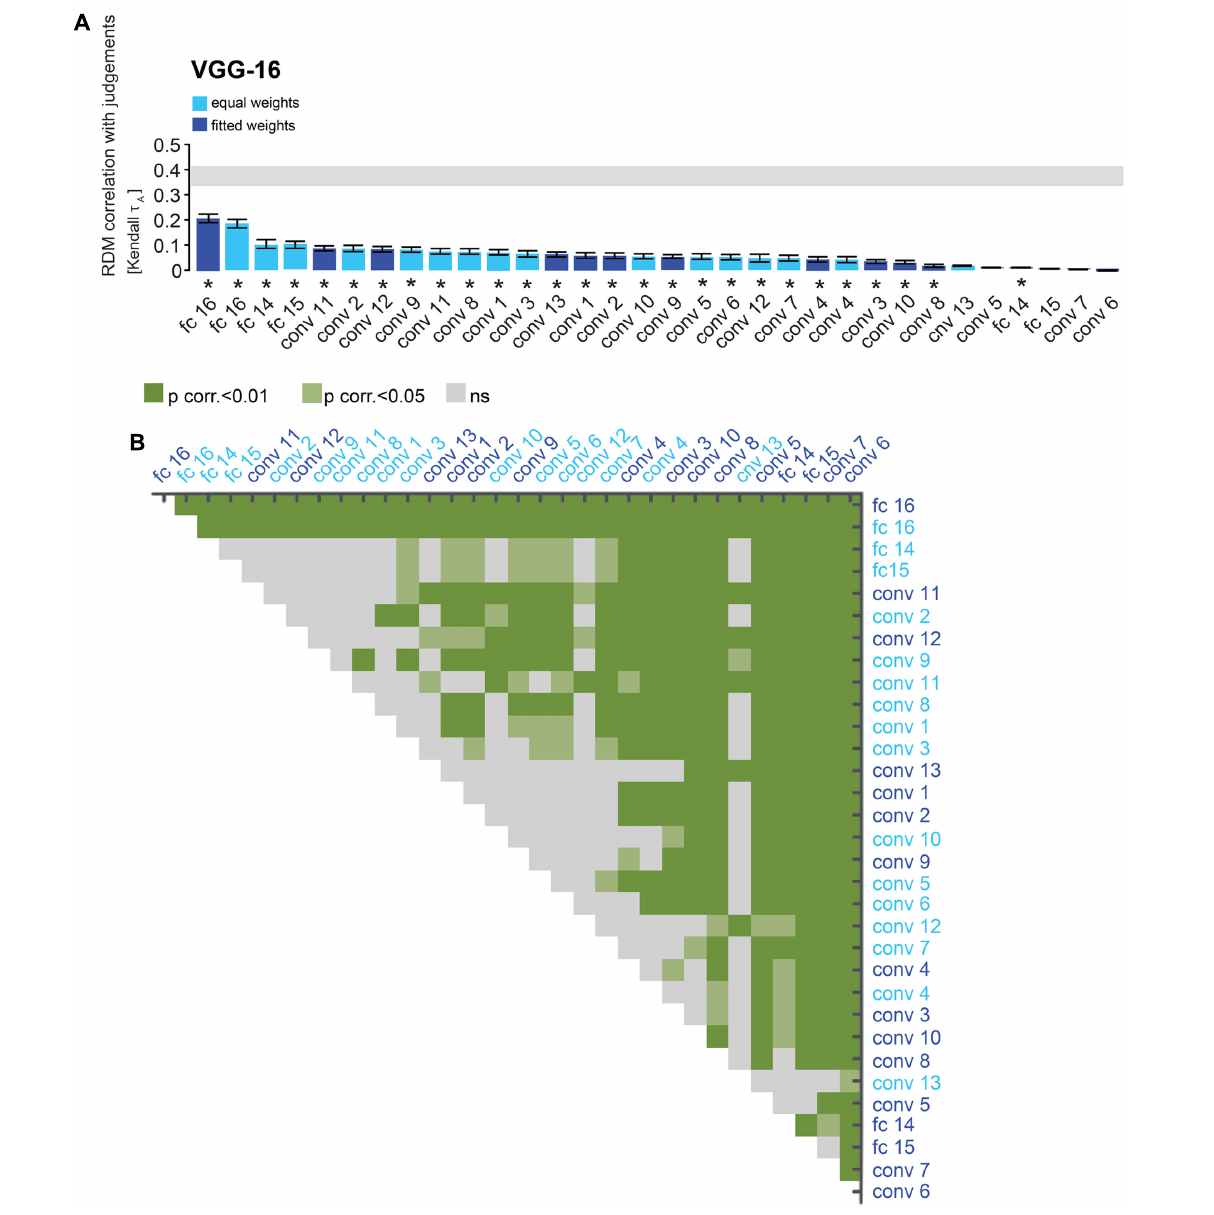
It is important to note that VGG-16 outperforms AlexNet on image classification (29.5% top-1 error rate and 42.6% top-1 error rate, respectively) but is not better at explaining the similarity judgments. This suggests that the additional depth and superior classification performance of VGG-16 may not be advantageous in explaining human object similarity